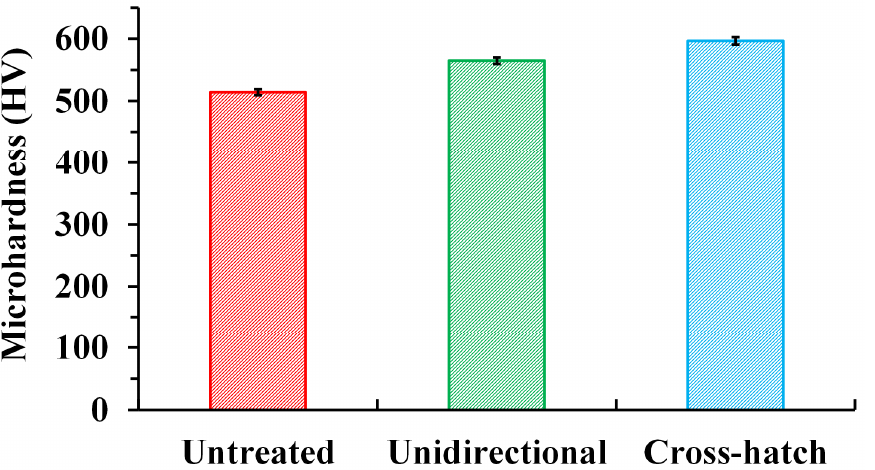
Figure 11. Microhardness measurements for untreated surface, laser textured BMG surface with unidirectional pattern, and laser textured BMG surface with cross-hatch pattern.